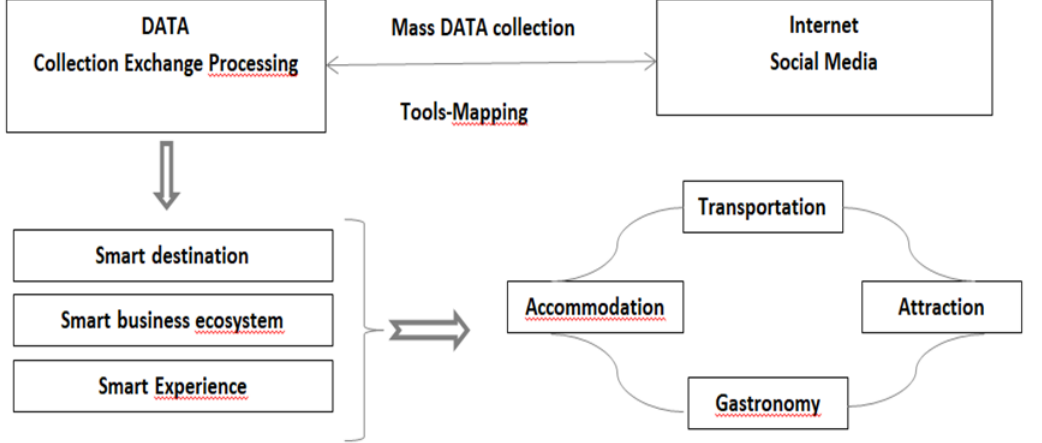
Figure 4: Spatial tourism/ Big Data-Map